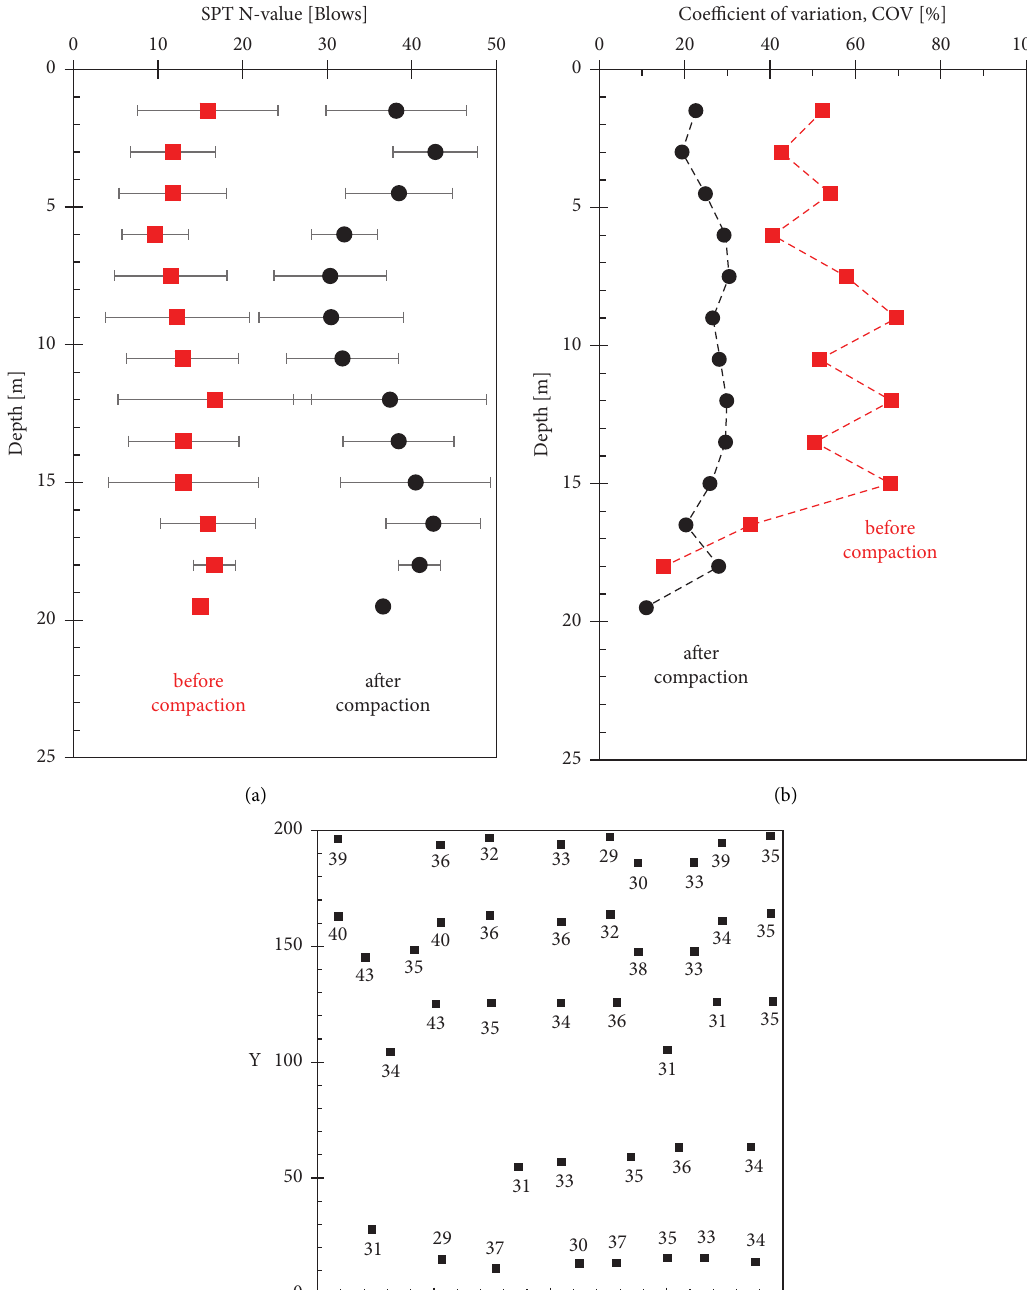
Figure 2: Depth profile of statistical characteristics of SPT N value: (a) mean and standard deviation for N -values measured before and after dynamic compaction (DC); (b) coefficient of variation COV of SPT N -values before and after dynamic compaction; and (c) the location map of average SPT N after